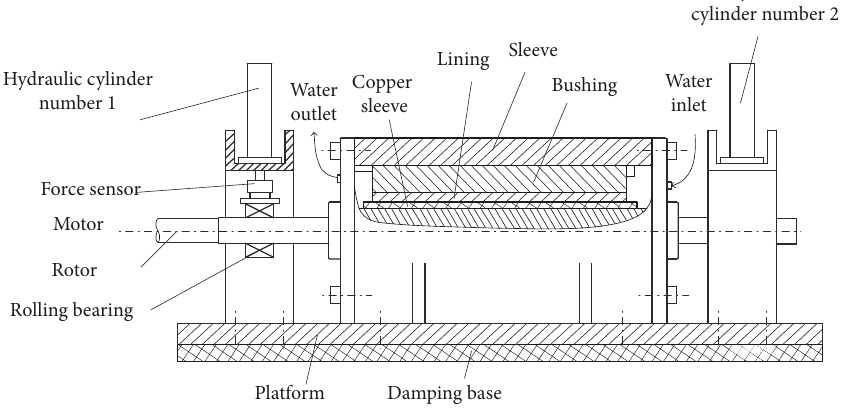
Figure 1: Schematic diagram of the test rig.